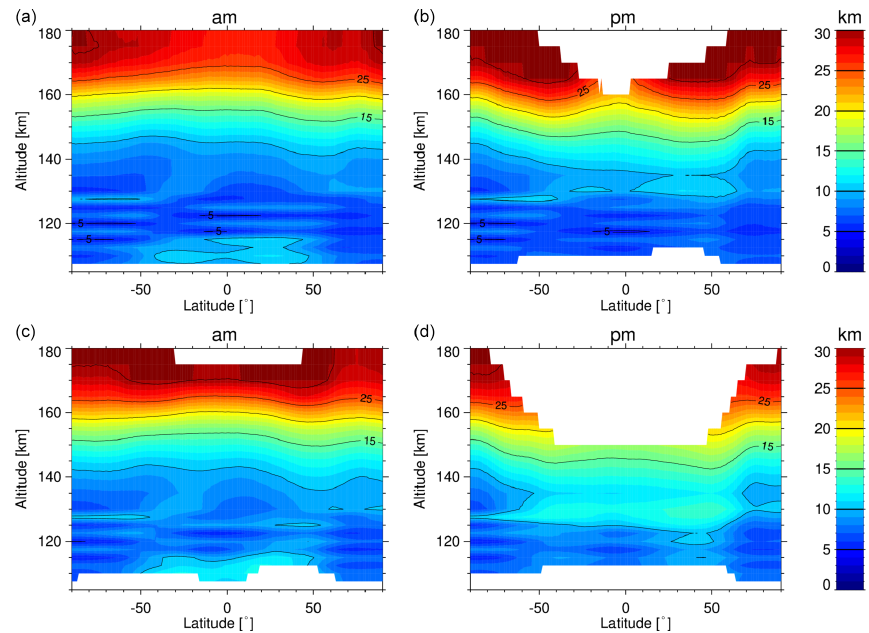
Figure 3. Zonal mean vertical resolution (in terms of full width at half maxima of the AK rows) of the retrieved temperature in the lower thermosphere from UA measurements as a function of latitude and altitude, separated for (a, c) morning and (b, d) afternoon, as well as for high-solar-activity conditions (averaged over the years 2005, 2006, 2011, and 2012, a, b ) and low-solar-activity conditions (averaged over the years 2007–2010, c, d ).